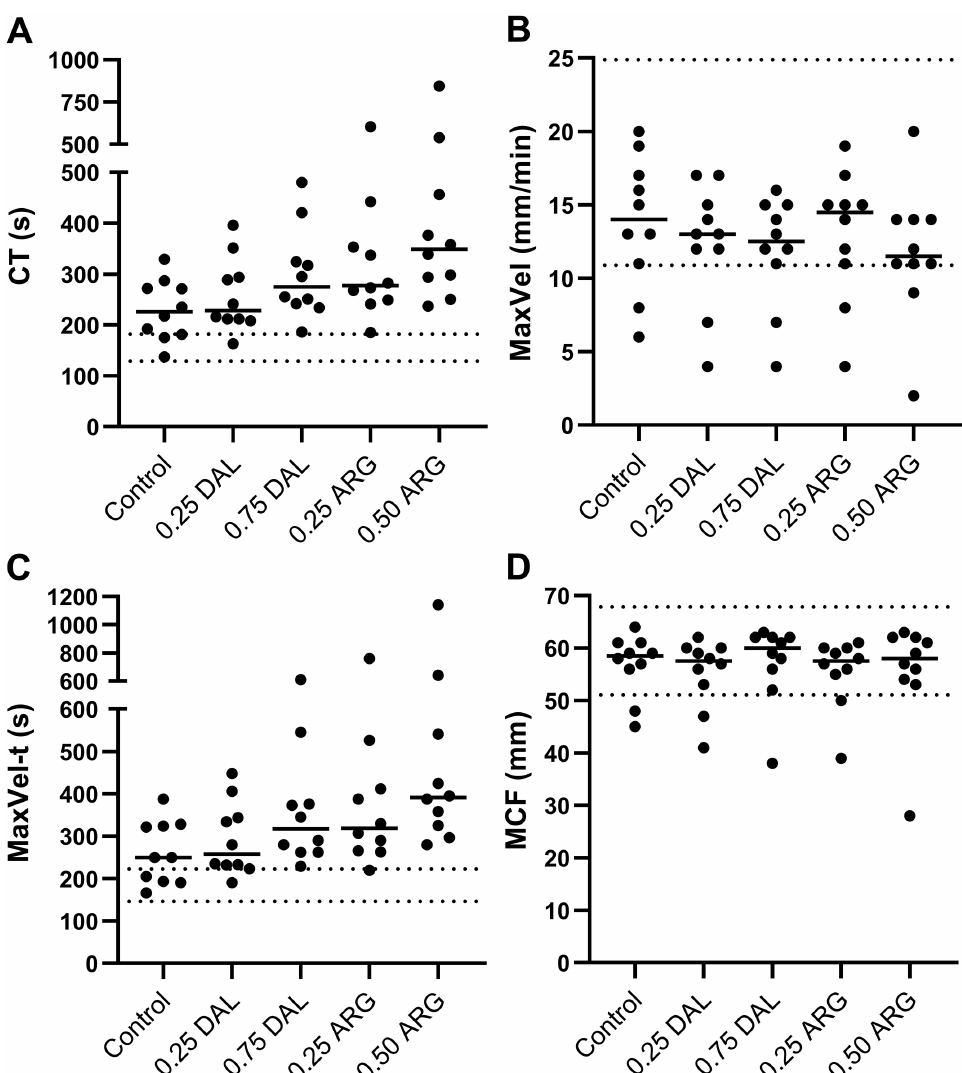
Fig. 4. (A) Clotting time (CT), (B) maximum velocity (MaxVel), (C) time to maximum velocity (MaxVel-t), and (D) maximum clot fi rmness (MCF) evaluated by INTEM in whole blood samples without anticoagulant (Control), 0.25IU/mL and 0.75IU/mL dalteparin samples (DAL), and 0.25 µg/mL and 0.50 µg/mL argatroban samples (ARG) from critically ill sepsis patients with new-onset thrombocytopenia ( n ¼ 10). Data are shown as individual values. Solid lines are group medians and dotted lines are reference